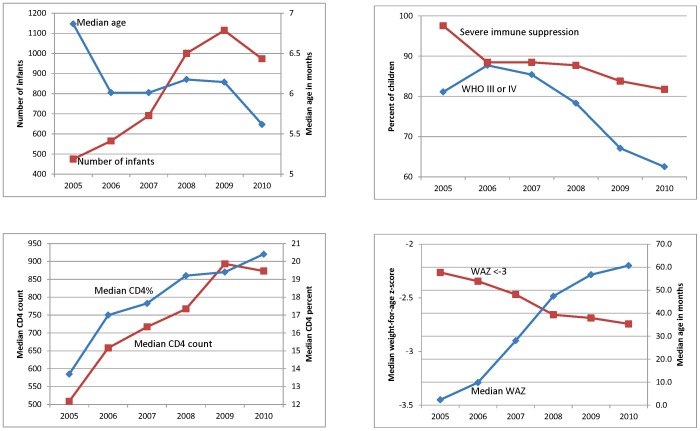
Characteristics of children <1 year of age at ART start by program year.Characteristics of children <1 year of age at ART start by program year summarized as medians for continuous variables and proportions for categorical variables. p<0.001 for changes over program year for all variables (Cuzick's test for trend for continuous variables and logistic regression for categorical variables).